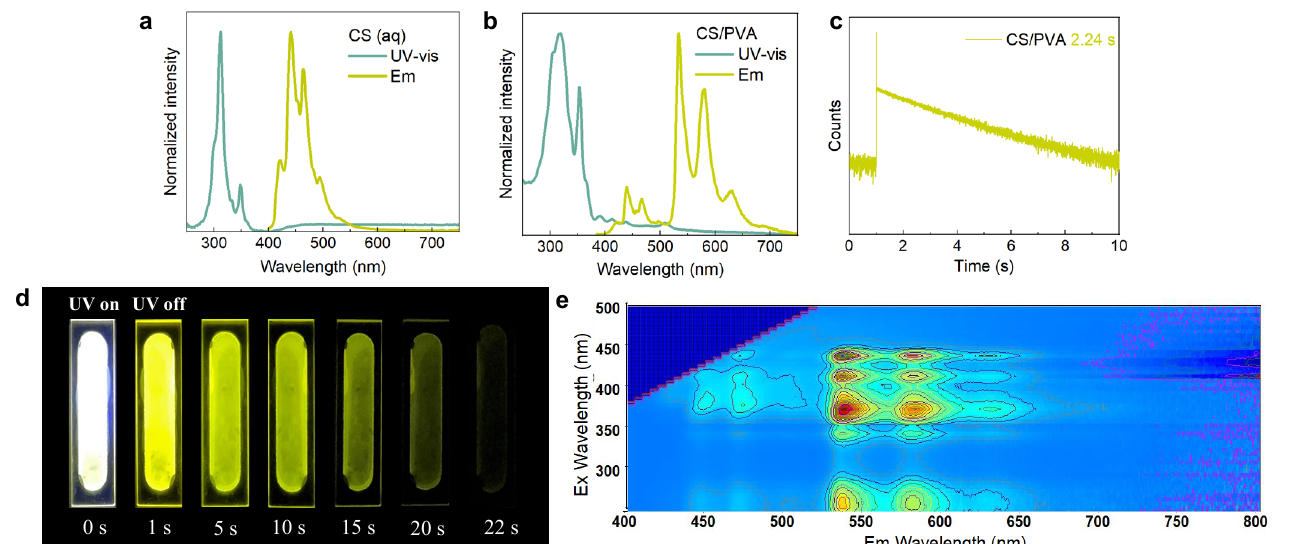
Figure 2. ( a ) Normalized UV-Vis spectrum and photoluminescence spectra of CS in aqueous solution ( λ exc. = 365 nm); ( b ) normalized UV-Vis spectrum and photoluminescence spectra ( λ exc. = 365 nm) of CS/PVA hybrids; ( c ) RTA phosphorescence lifetime curve of CS/PVA hybrids ( λ exc. = 365 nm, λ monitor = 540 nm); ( d ) photographs of the long-lasting luminescence of the CS/PVA film with the UV light excitation on and off; ( e ) excitation–emission mapping of CS/PVA hybrids ( λ exc. = 250–500 nm, λ em. = 400–800 nm).